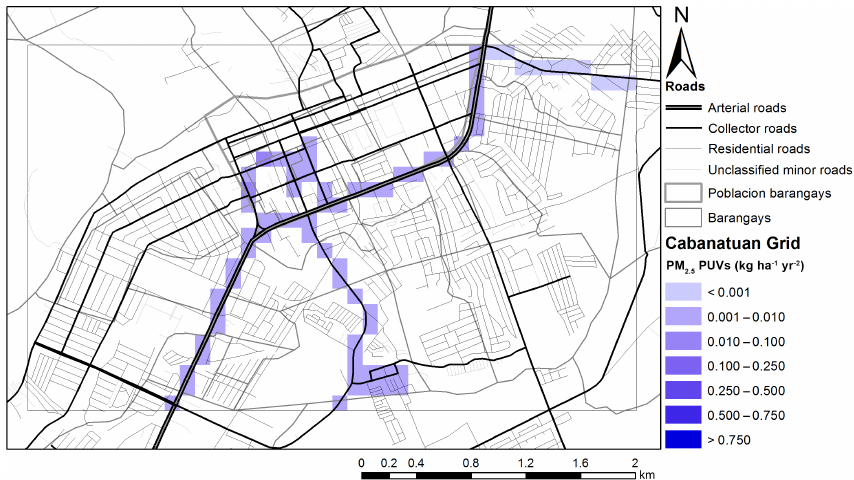
Figure 7. Map of estimated PM 2 . 5 emissions from PUVs (public utility vehicles/jeepneys/XLTs). Base map derived from satellite imagery (Google Earth Pro, 2015,